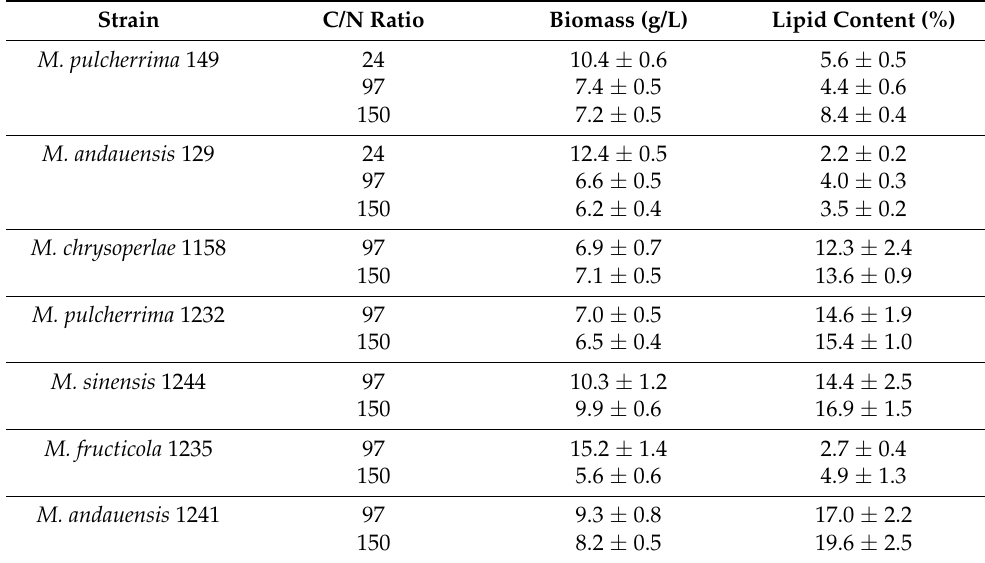
Table 2. Effect of the C/N ratio at low temperature on the biomass and lipid production